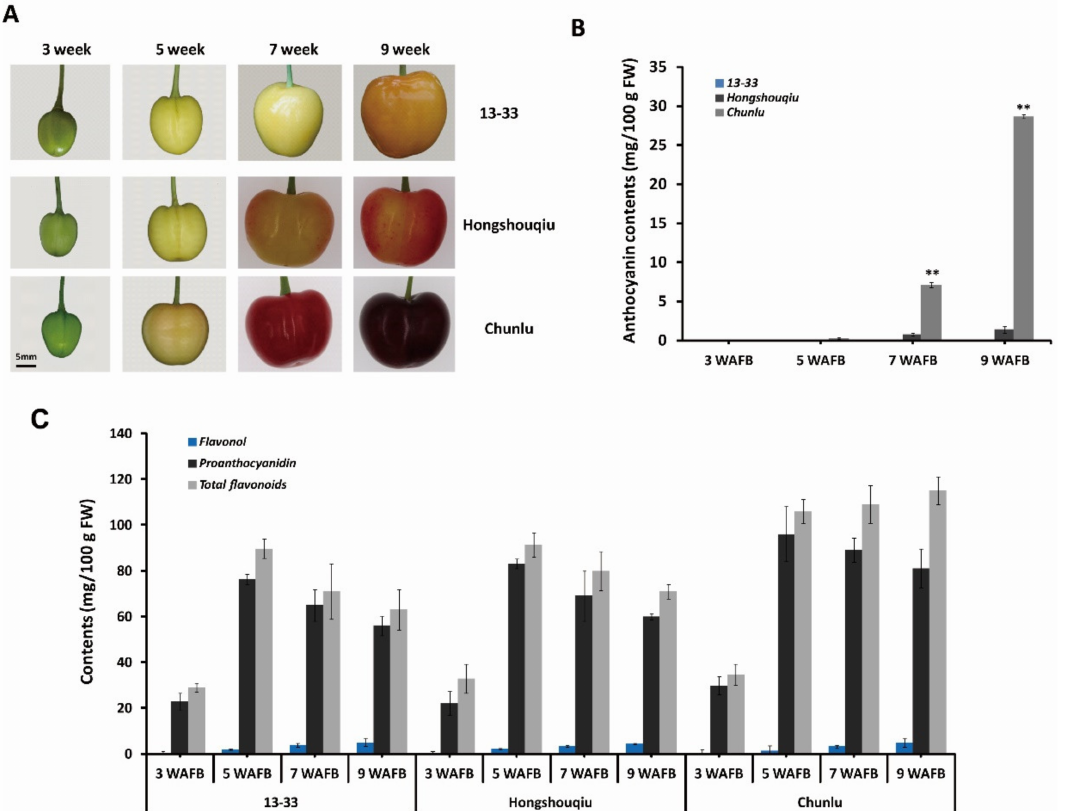
Figure 1. Developing fruits ( A ) and anthocyanin ( B ), proanthocyanidin ( C ), flavonol ( C ), and total flavonoid ( C ) contents measured 3, 5, 7, and 9 weeks after full bloom (WAFB) in sweet cherry varieties Chunlu, Hongshouqiu, and 13–33. Scale bar indicates 5 mm. Values are means ± SD from six independent biological replicates. ** Significant differences as calculated using the Student’s t -test at p <